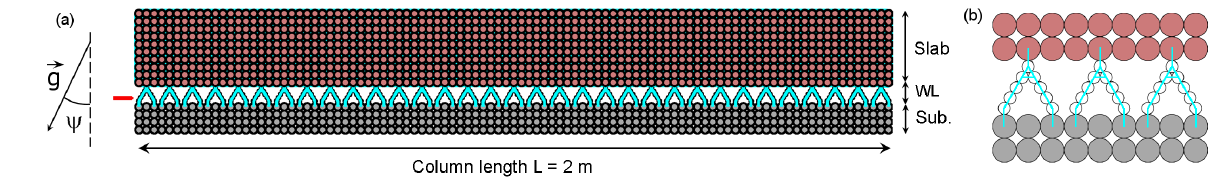
Figure 4. (a) Simulated system of the propagation saw test (PST) composed of a slab, a weak layer and a rigid (fixed) substratum. The column is 2m long. (b) Zoom on the weak layer structure. The blue lines represent the weak layer bonds.